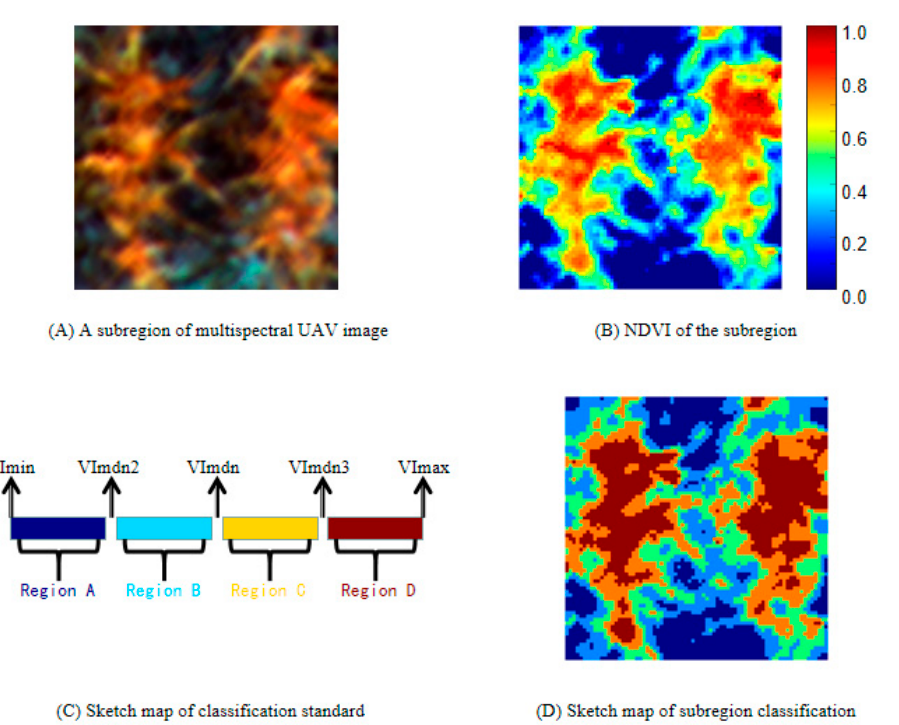
Figure 8. NDVI value ( B ) of wheat images ( A ) were obtained and graded ( C ) to obtain gradient feature classification map ( D ).